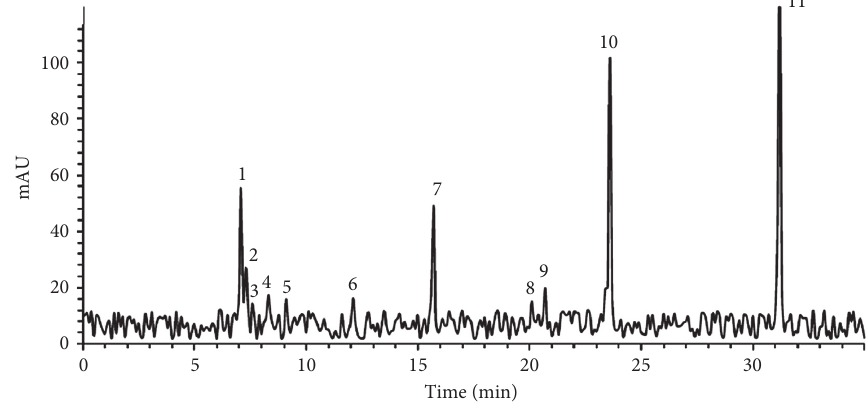
Figure 2: LC-MS analysis of the root of A. floccosus